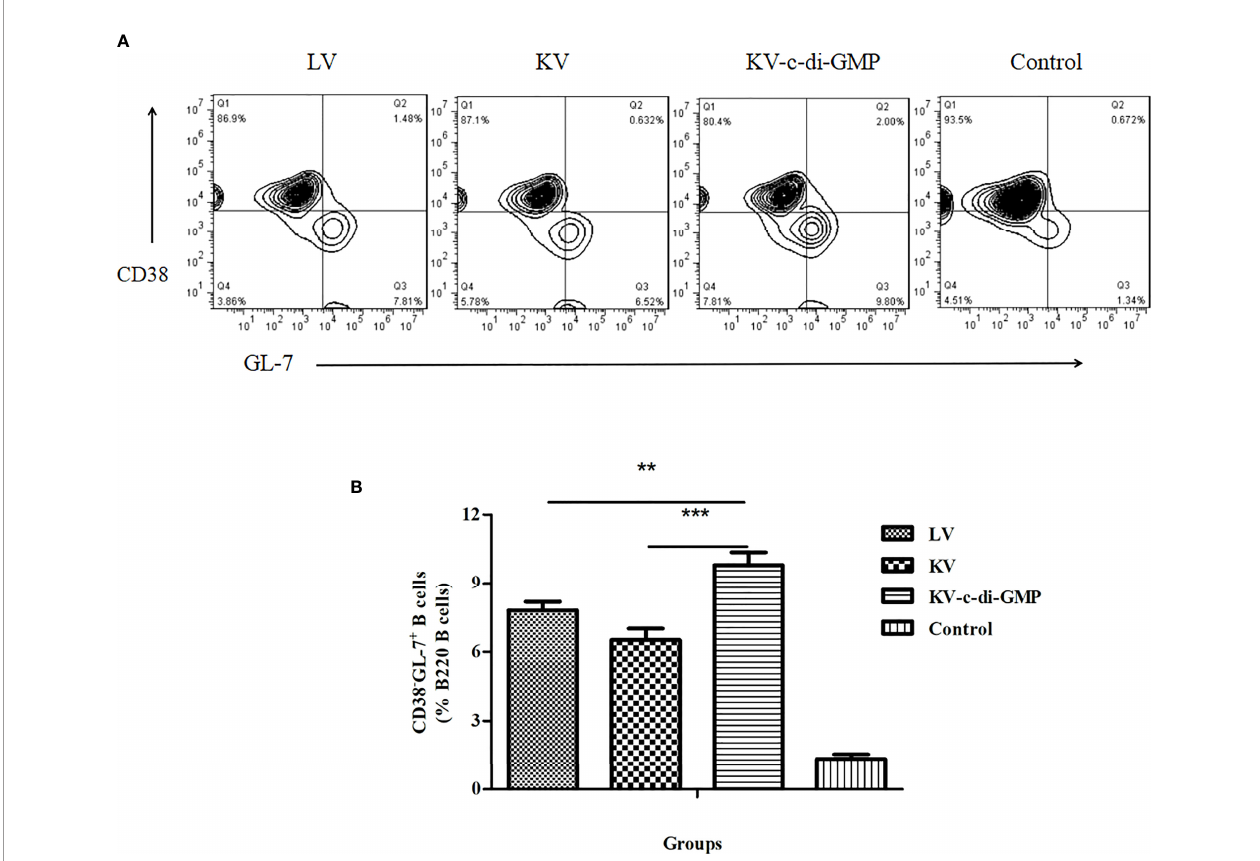
FIGURE 4 | Frequencies of GC B cells in the LNs of the four groups at 28 dpi. (A) FACS analysis of B220 + CD38 - GL-7 + B cells. (B) Mean frequencies ± standard deviation of B220 + CD38 - GL-7 + B cells. Data represent three independent experiments. Pooled LNs from three mice were processed independently three times. ** P < 0.01; *** P <